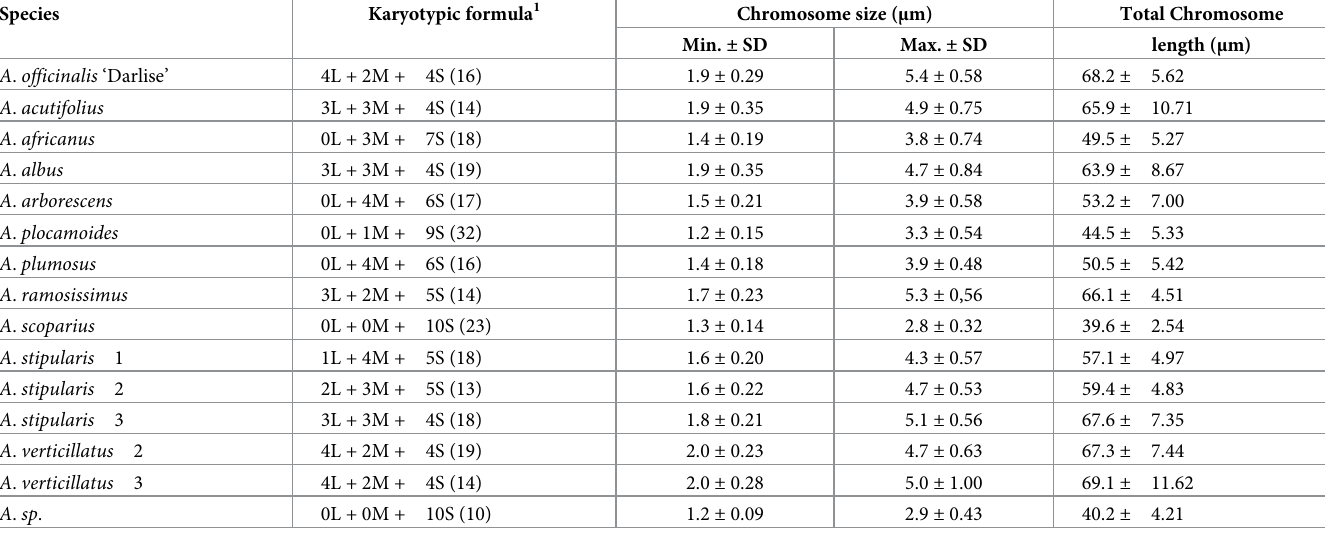
Table 2. Determined karyotypic formula of diploid Asparagus accessions such as minimum and maximum size of the measured chromosomes.